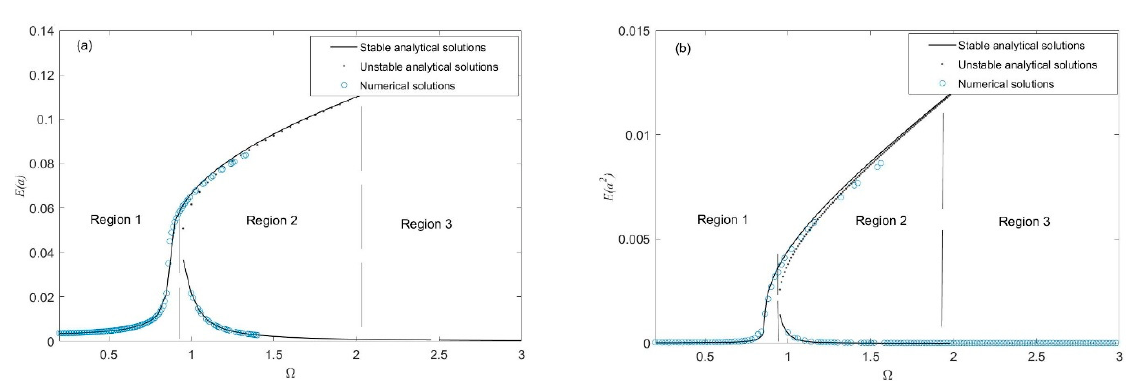
Figure 4. Frequency–amplitude responses of the SMA oscillator system (11) for different parameters: ℎ = 0 , 𝜁 = 0.1 , 𝛽 = −1.3 × 10 (cid:2871) , 𝛾 = 4.7 × 10 (cid:2873) . ( a ) Temperature 𝜃 , 𝑓 = 0.03 ; ( b ) amplitude 𝑓 of the external excitation, 𝜃 = 1.9 .